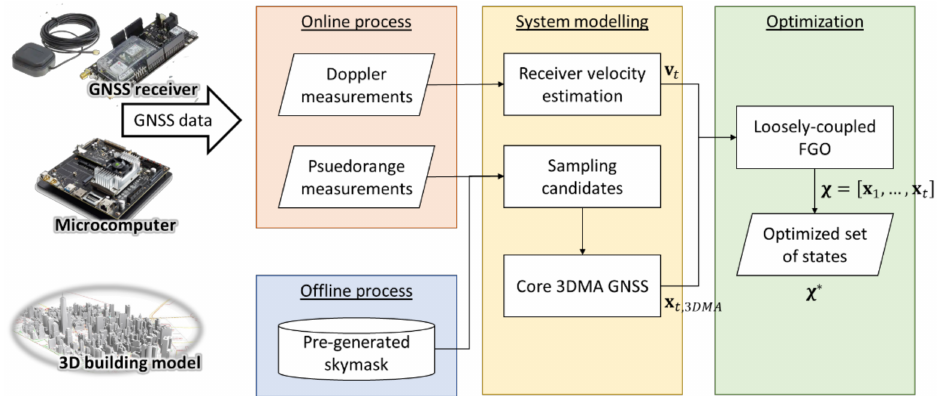
Figure 1. System flowchart on the proposed